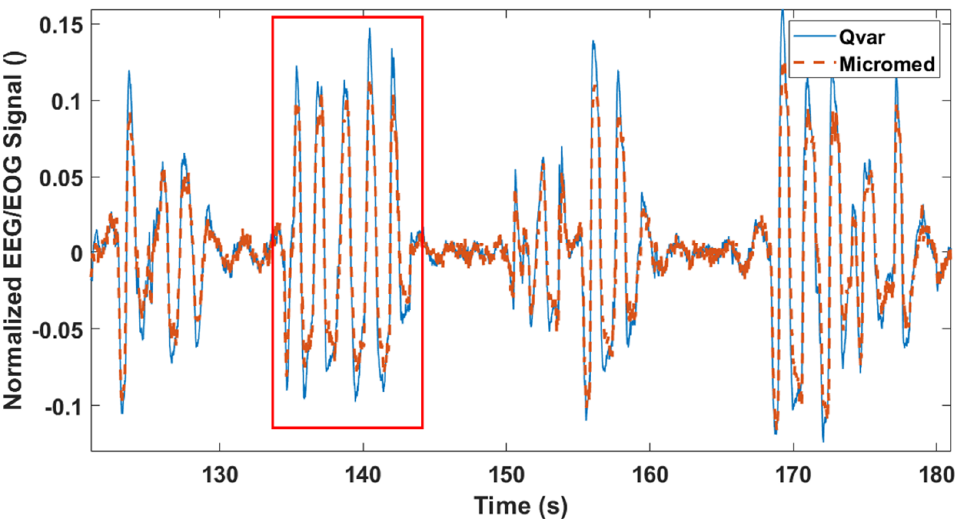
Figure 17. EOG trace recorded from ST−Qvar and the gold standard during clockwise eye move- ments. A single window of the eye movements is highlighted with a rectangle.